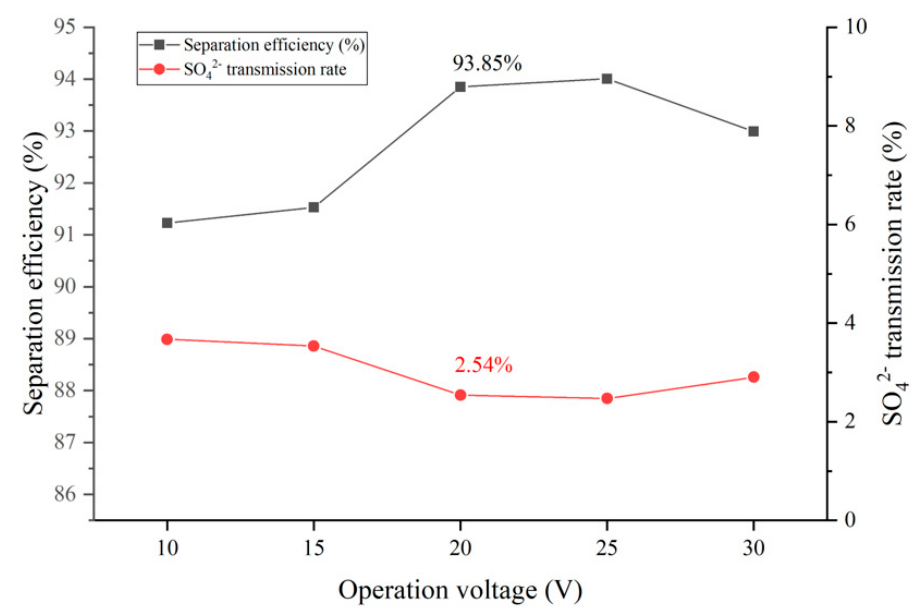
Figure 5. Influence of voltage on selection separation performance of the device.